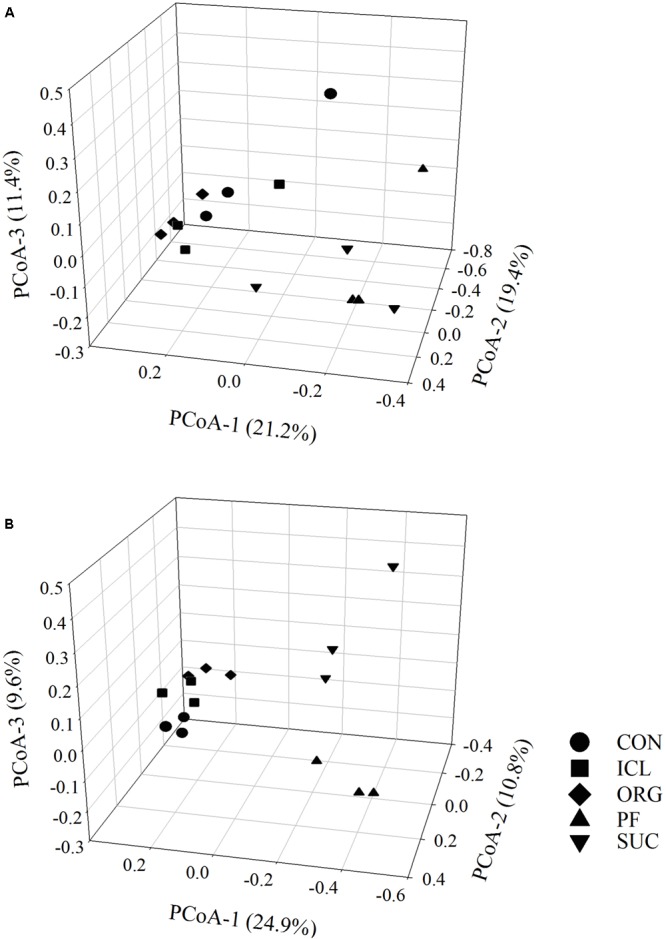
Principal coordinates analysis (PCoA) of bacterial (A) and fungal (B) communities in five systems including conventional cropping (CON), integrated crop-livestock (ICL), organic cropping (ORG), plantation forestry (PF), and natural succession (SUC). Variation explained by each principal coordinate dimension is given in percentage.